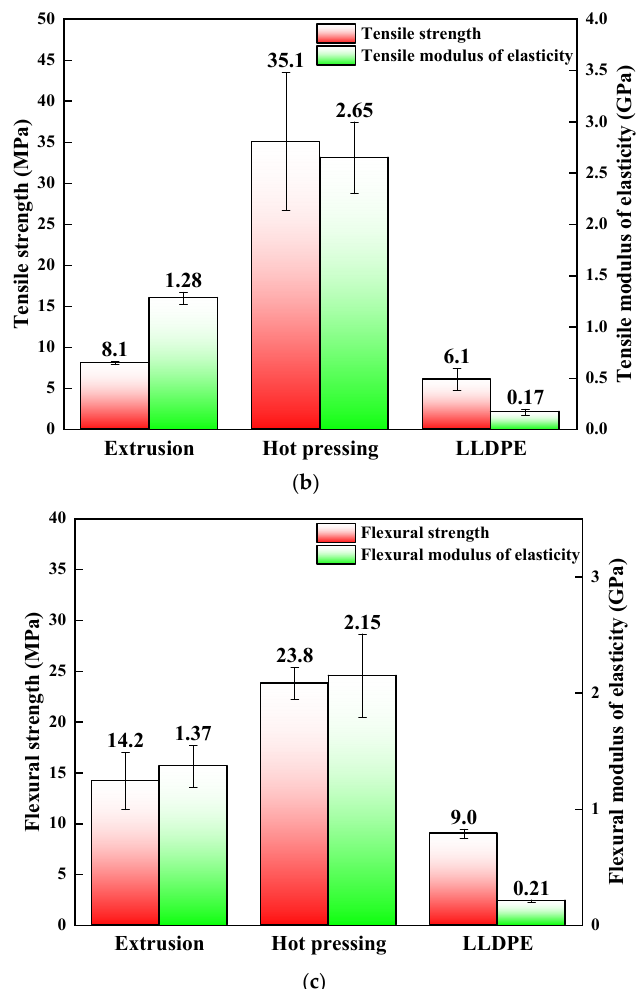
Figure 3. Impact strength ( a ), tensile properties ( b ) and bending properties ( c ) of hot pressed and extruded straw/LLDPE composite.